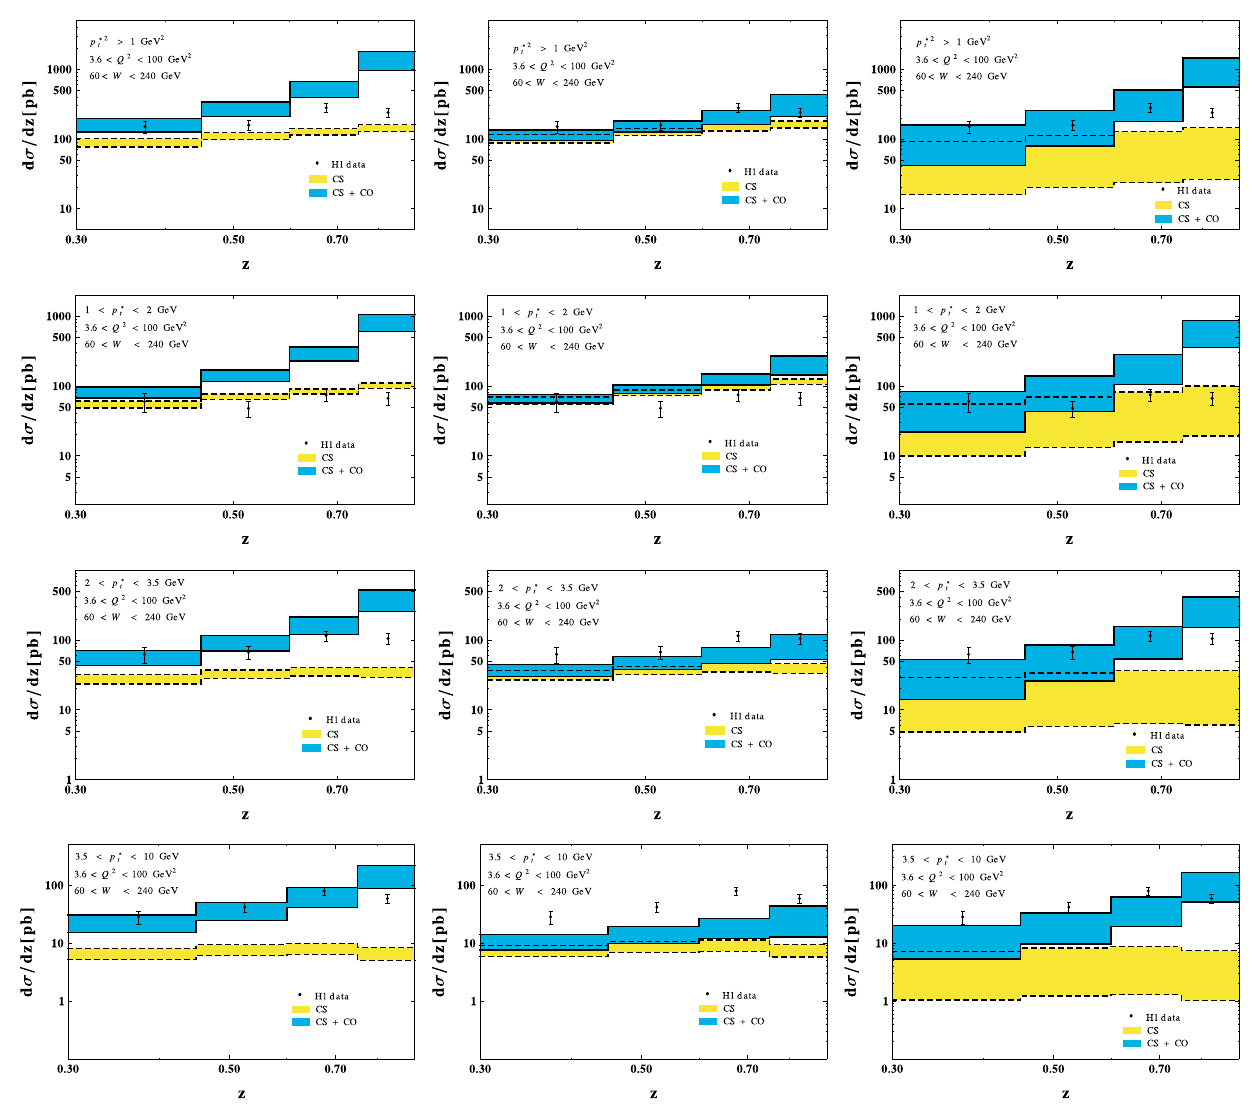
Fig. 16 The differential cross sections for the J /ψ production in DIS with respect to y (cid:11) ψ . The experimental data are taken from Ref. [50]. The l.h.s., middle, and r.h.s. plots correspond to the LDMEs taken in Refs. [28,30,41],